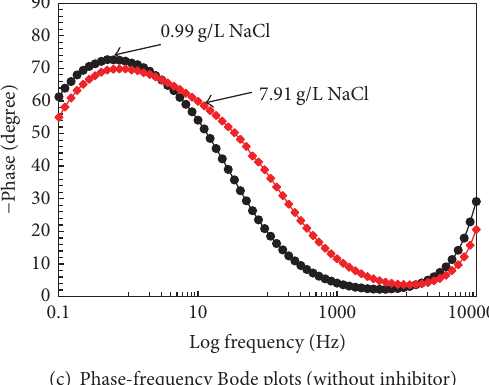
solution are shown in Figure 3(b). The impedance